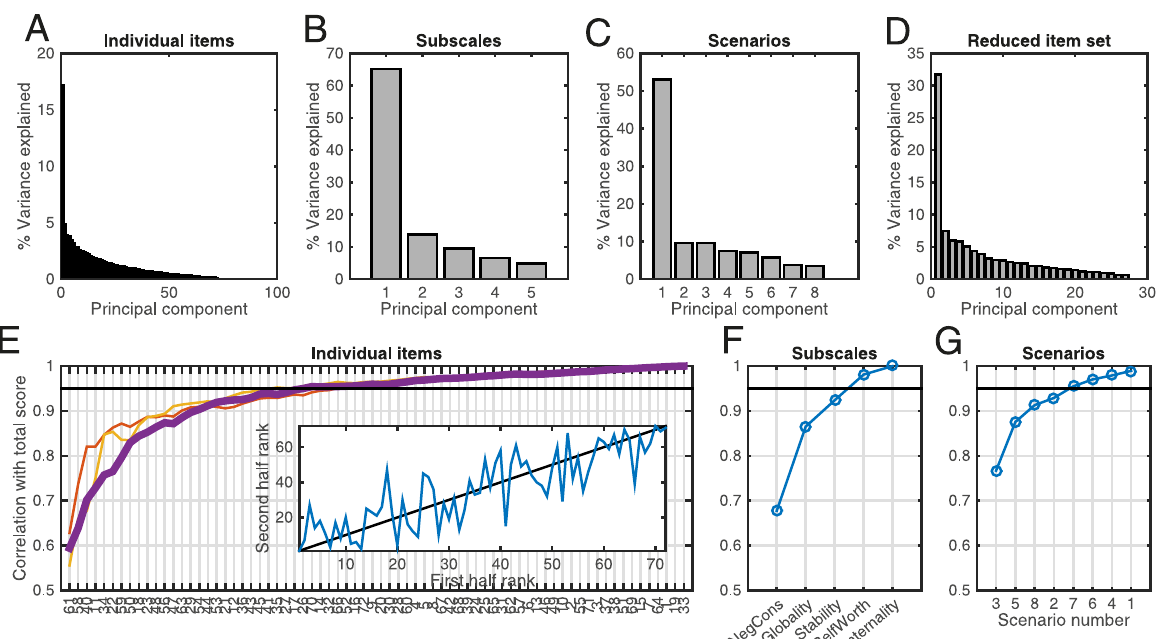
Fig 1. Component structure of the CSQ-SF-D. A-D : PCA results: variance explained (normalised eigenvalues) across individual items (A), across the five subscales (B), across the eight scenarios (C) and across the reduced set of 27 items for the very short form (E). E : Correlations of subscales composed of increasing number of items highly correlated with total score. The leftmost point shows the correlation of the most predictive item (61). Going towards the right, the second-most predictive item is added, and the correlation of the sum across these two items with the total score is shown. As the most informative items are added, the correlation with the total score increases rapidly and then flattens of. The level of 0.95 correlation is reached at around 27 items in the full dataset (thick line), and also in the two split-half datasets (thin lines). Inset: Individual item rankings in terms of correlations with total score are similar across the two halves of the dataset (correlation = 0.84, p < 1 − 20 ). F , G Analysis as in E, but across subscales (F) and scenarios